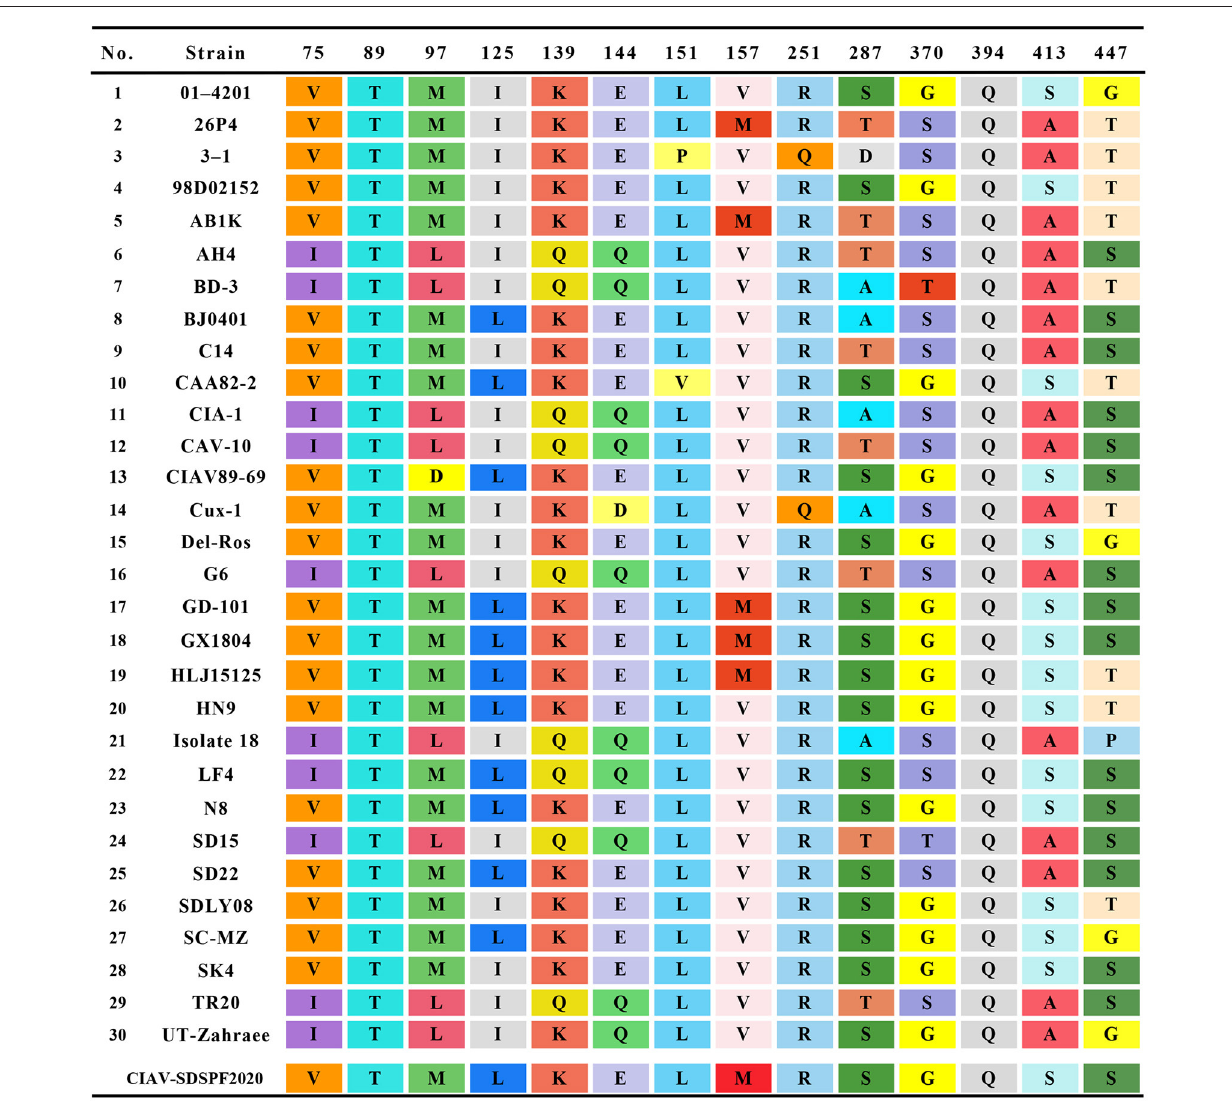
FIGURE 3 | Amino acids at sites of common substitutions in VP1 protein coding sequences of different CIAVs. Each site differences are indicated by different color base box. The last row in the table shows the sites of the new